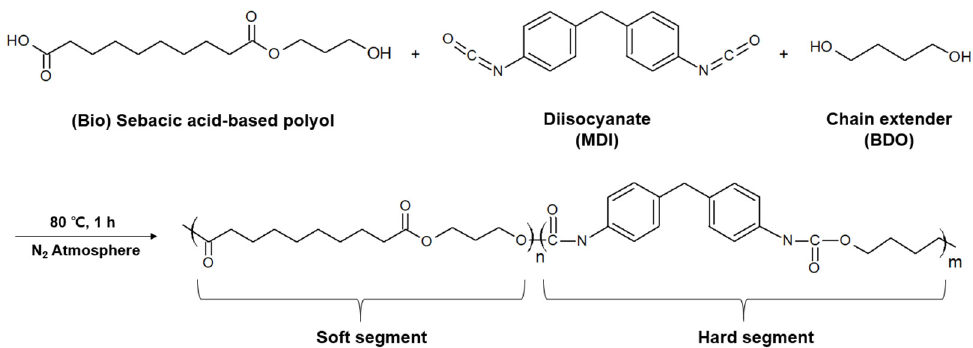
Figure 1. Schematic diagram of TPU synthesis mechanism.